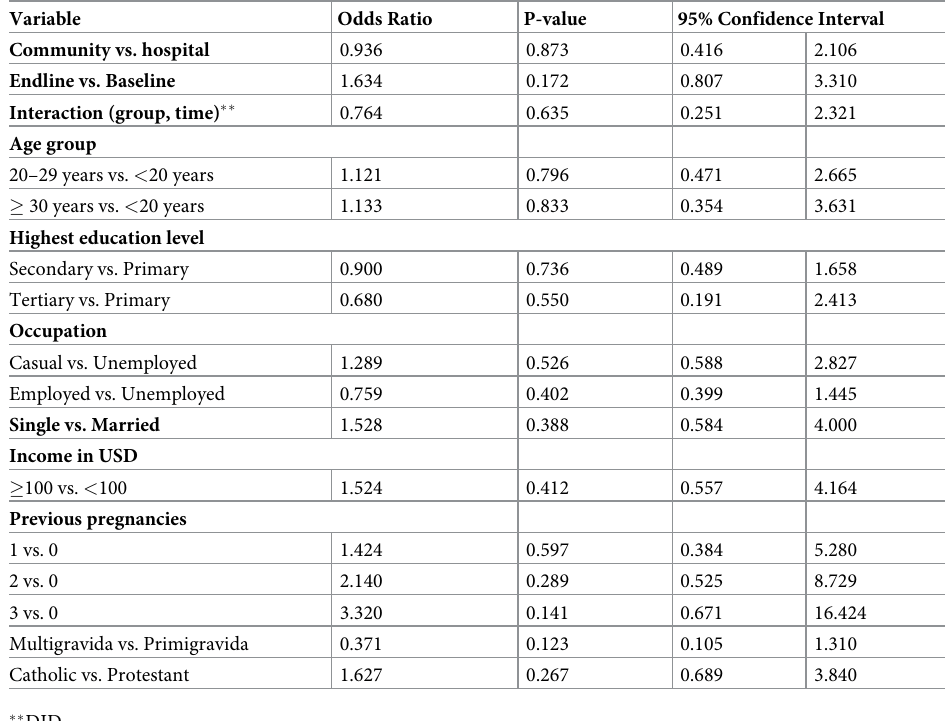
Table 3. Factors associated with maternal compliance with